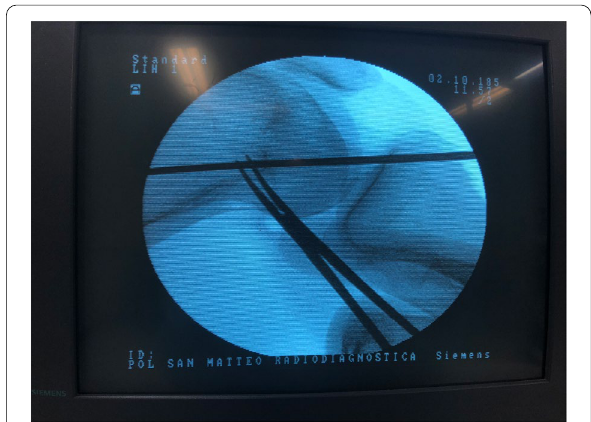
Fig. 2 Identification of the femoral insertion point of the MPFL